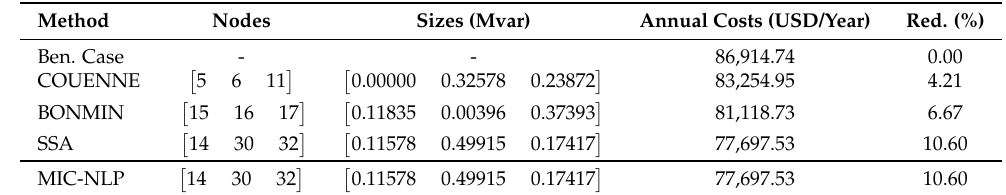
Table 8. Optimal solutions reached by the comparison and proposed optimization methods with variable reactive power injection in a meshed grid